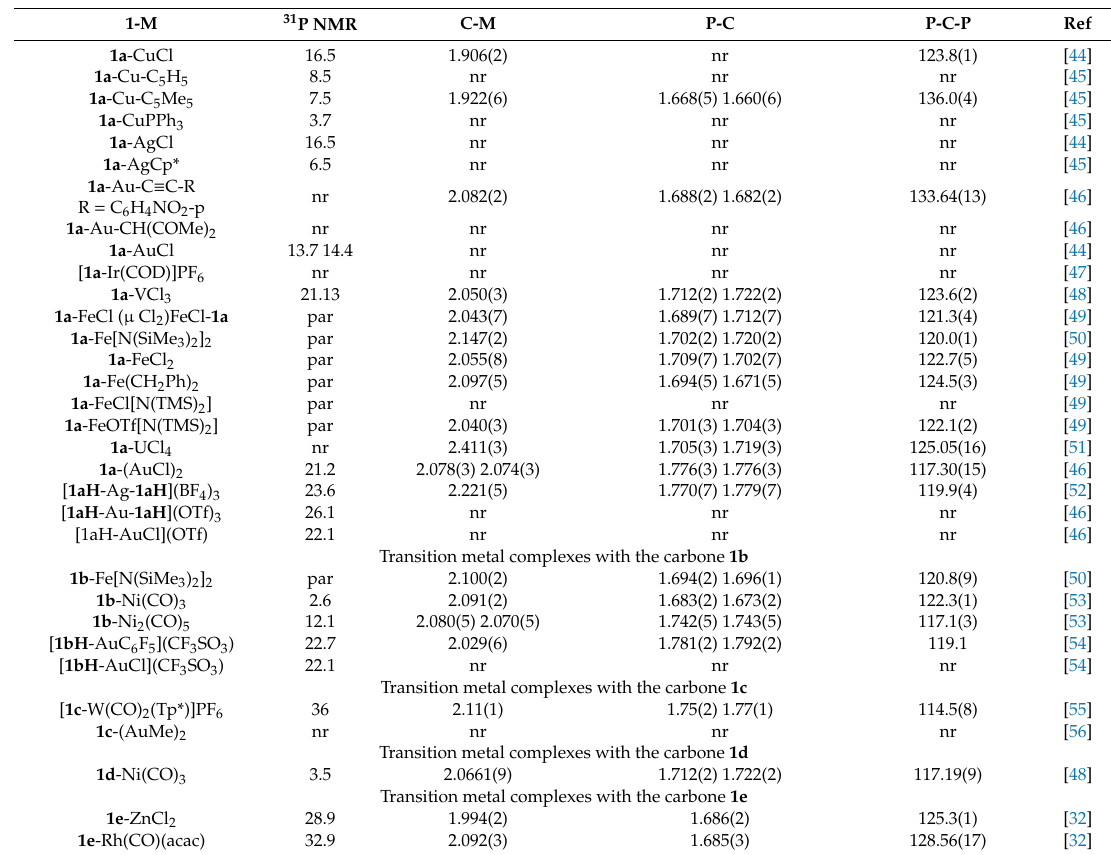
Scheme 3. Selected transition metal compounds with the carbone 1a as four electron donor ligand.